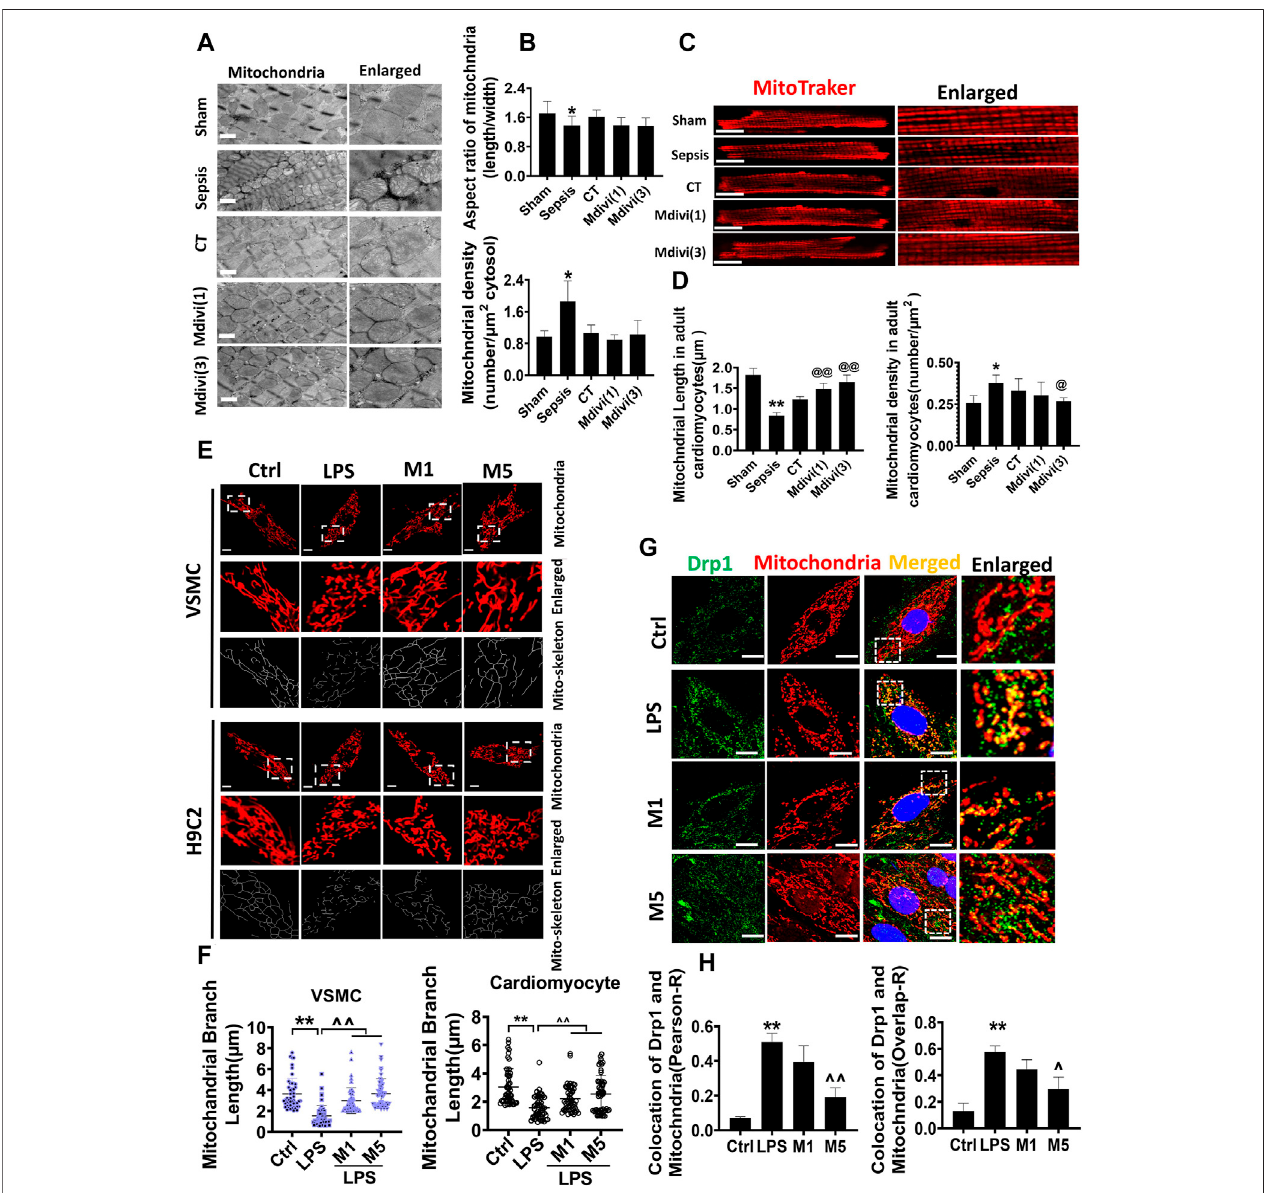
FIGURE 3 | Effects of Mdivi-1 on mitochondrial morphology in septic rats. (A-B) : mitochondrial morphology of heart by transmission electron microscope (TEM) and statistical analysis (bar (cid:1) 500 nm). (C,D) : mitochondrial morphology of acute isolation of cardiomyocytes in vitro and statistical analysis (bar (cid:1) 25 µm). (E-F) : mitochondrial morphology of cardiomyocytes and vascular smooth muscle cell by laser confocal microscopy and statistical analysis (bar (cid:1) 25 µm); (G,H) : colocalization ofmitochondriaandDrp1(bar (cid:1) 25 µm).* p < 0.05,** p < 0.01versusshamorctrl.@ p < 0.05,@@ p < 0.01versusconventionaltreatment(CT)group. ^ p < 0.05, ^^ p < 0.01 versus LPS. Sham (cid:1) the control group, Sep (cid:1) sepsis, CT (cid:1) conventional treatment. 1: Mdivi-1 (1 mg/kg). 3: Mdivi-1 (3 mg/kg). H9C2: cardiomyocytes. VSMC: vascular smooth muscle cell. Ctrl: control group. M1: Mdivi-1 (10 µM). M5: Mdivi-1 (50 µM).